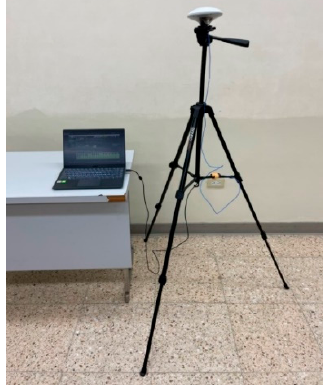
Figure 2. RTK ground station.